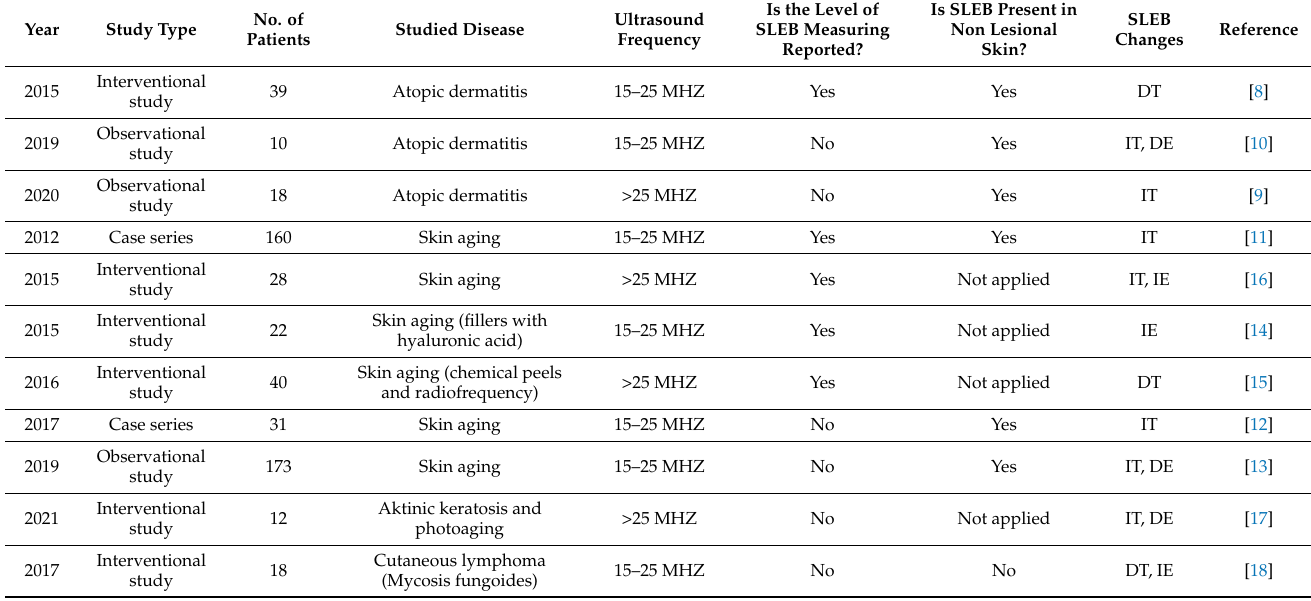
Table 1. Changes in SLEB thickness and echogenicity in different